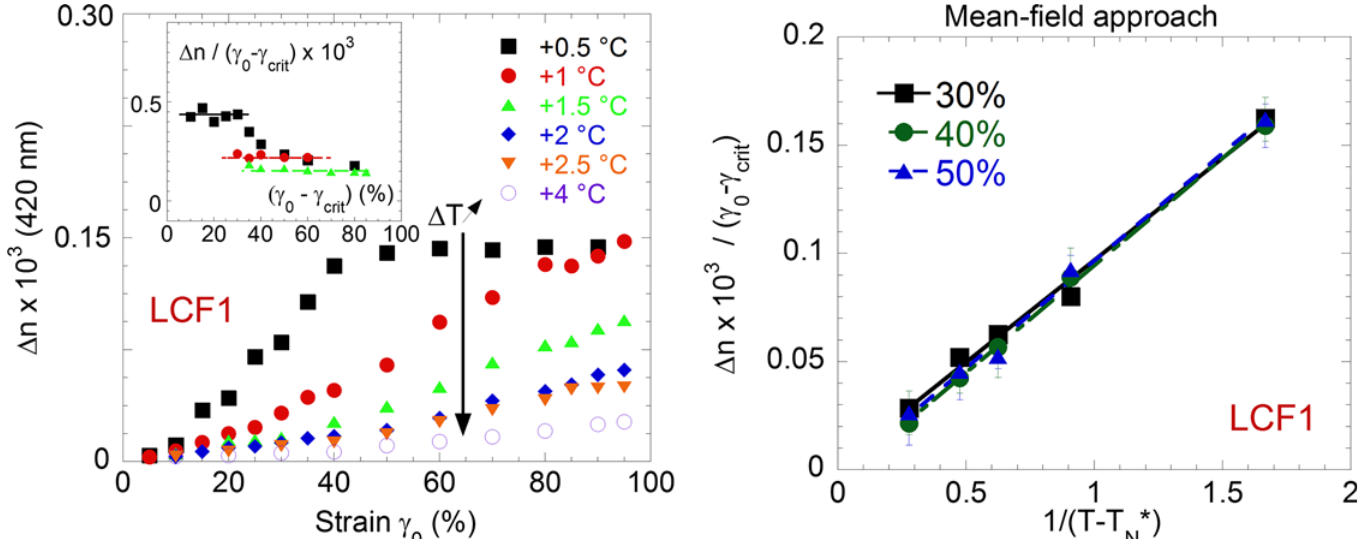
Fig 3. (a) Evolution of the low frequency birefringence (peak values) in the liquid phase versus strain amplitude γ 0 at various temperatures. Sample: LCF1 thickness: 250 μ m, ω = 1.0 Hz, at T-T NI = 0.5°C (black squares, & ), 1°C (red dots, ● ), 1.5°C (green triangles, ▲ ), 2°C (blue diamonds, ♦ ), 2.5°C (orange inversed triangles, ▼ ) and 4°C (purple circle, (cid:5) ). Insert: Reduced dynamic birefringence Δ n norm = Δ n/( γ 0 - γ crit ) versus strain amplitude. The eye-guide lines present a strain independent regime. (b) Mean field behavior of the low frequency birefringence at the approach of the transition temperature. The reduced dynamic birefringence is shown for three strain amplitudes γ 0: 30% (black squares, & ), 40% (green dots, ● ) 50% (blue triangles, ▲ ) as a function of 1/(T-T NI * ) with T NI * = T NI +0.4°C.